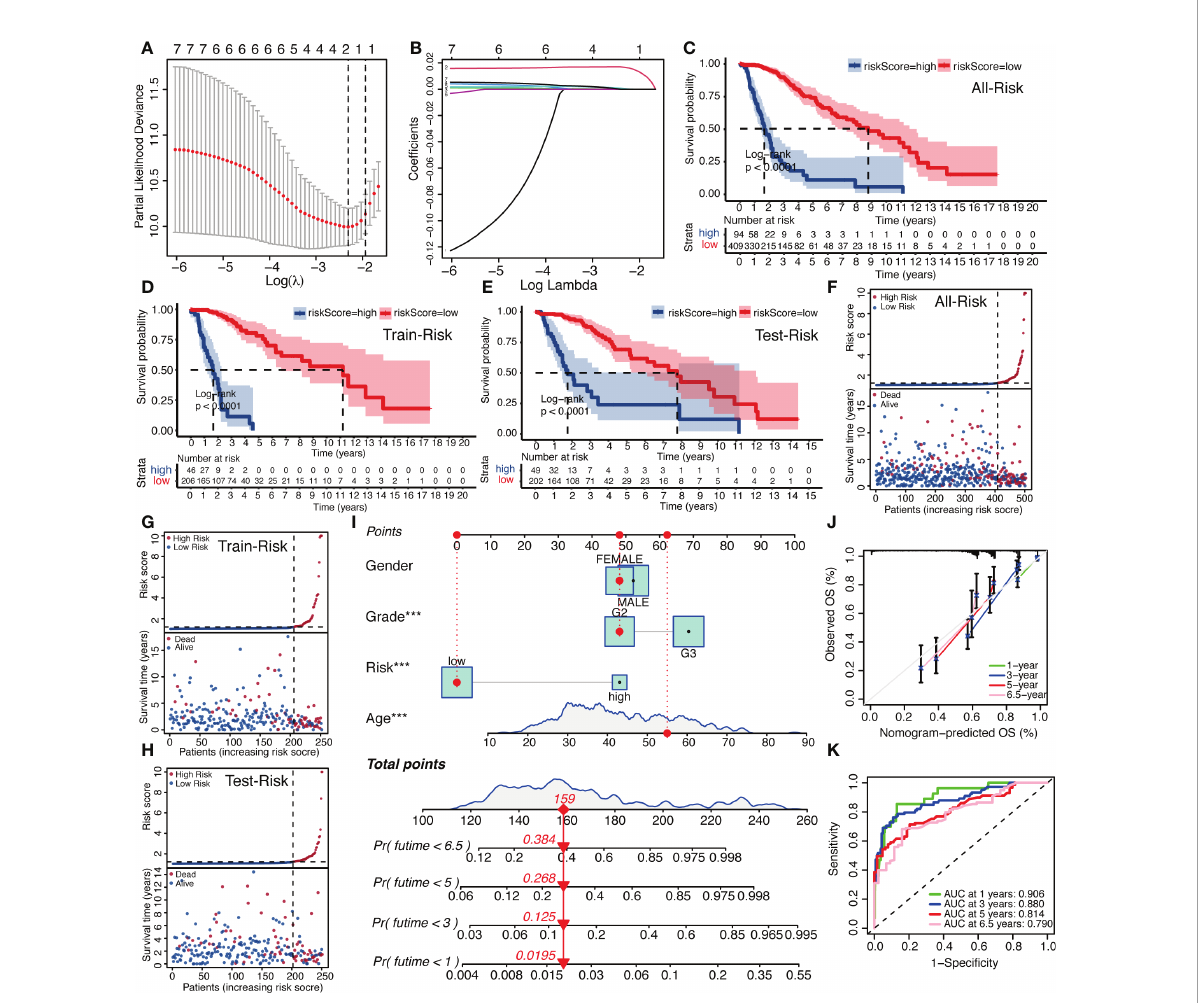
FIGURE 4 Establishment of IGFBPScore and prognostic prediction. (A, B) LASSO regression was performed, calculating the minimum criteria. (C – E) Kaplan – Meier curves for the full set, train set and test set in the TCGA glioma cohort. (F – H) Risk curve of IGFBPScore for the full set (F) , train set (G) , and test set (H) was plotted using the TCGA glioma cohort. (I) Nomogram based on IGFBPScore, age, gender and WHO grade. (J) Correlated plot indicated the accuracy of predictive ability. (K) ROC curves indicated the risk prediction ability of IGFBPScore at 1, 3, 5, and 6.5 years in the TCGA glioma cohort. For all experiments,